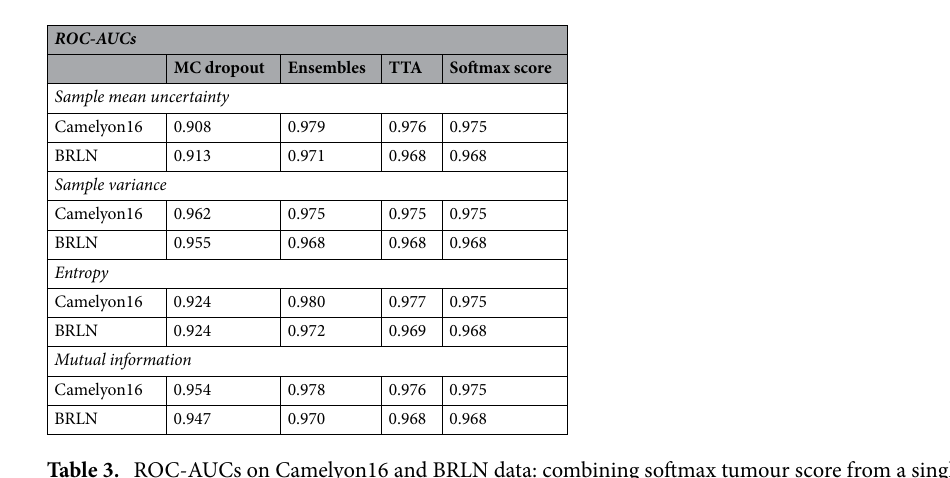
Table 3. ROC-AUCs on Camelyon16 and BRLN data: combining softmax tumour score from a single NN with uncertainty estimates. Softmax score refers to using the softmax output alone.